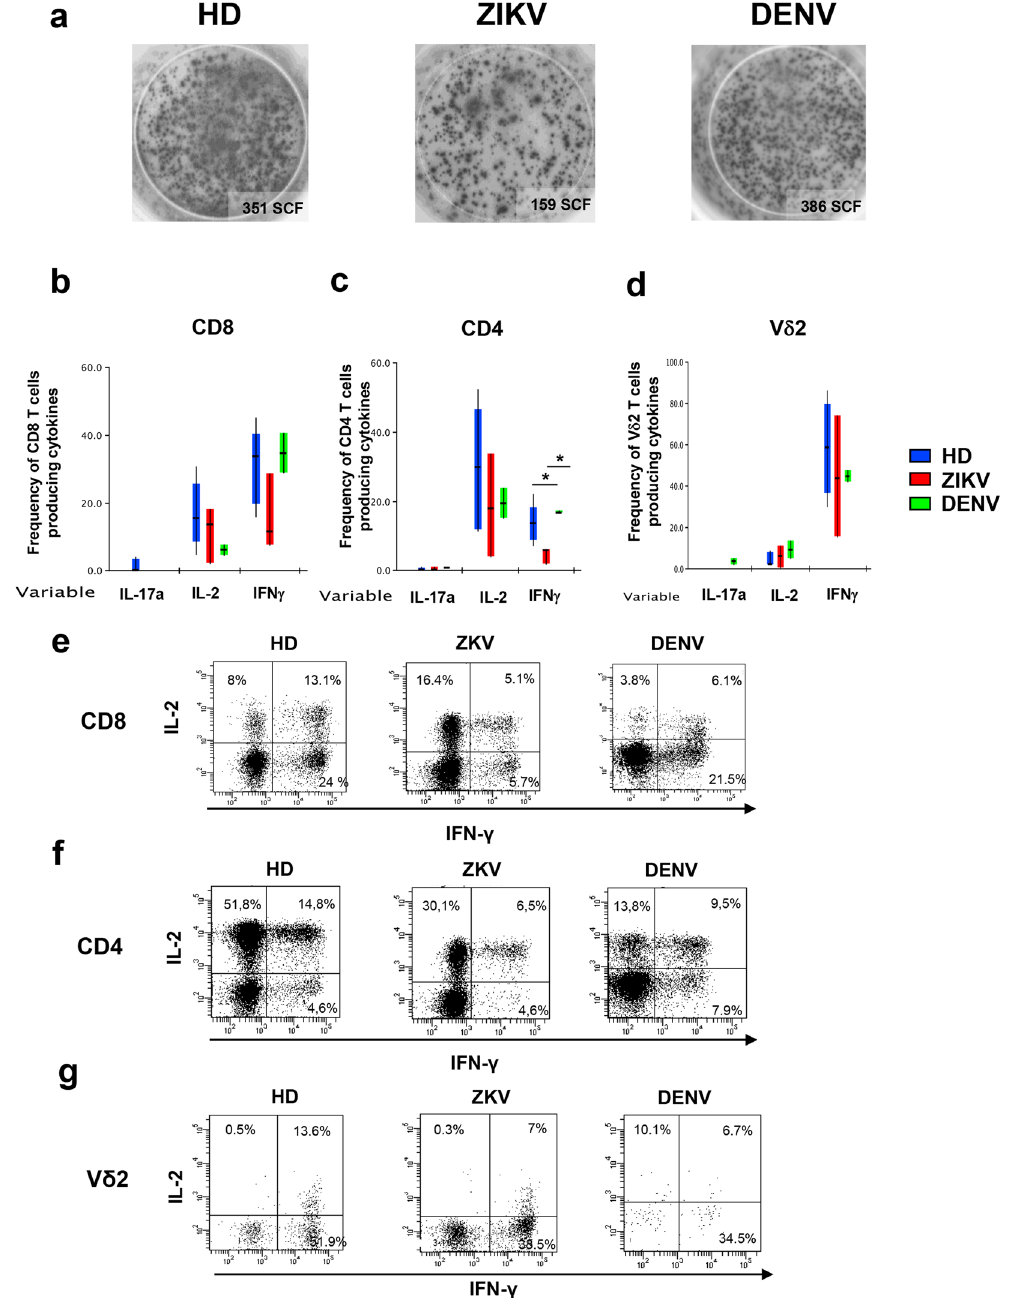
Figure 5. Functional profile of CD8 and CD4 T-cells response to ZIKV infection. IFN- γ production by T-cells after PHA stimulation was analyzed by EliSpot assay ( a ). The frequency of CD8 ( b ), CD4 ( c ) and V δ 2 ( d ) T-cells producing IL-17A, IL-2 and IFN- γ after PMA/Ionomycin stimulation is shown in ZIKV (red bars), DENV (green bars) and HD (blue bars). * p <